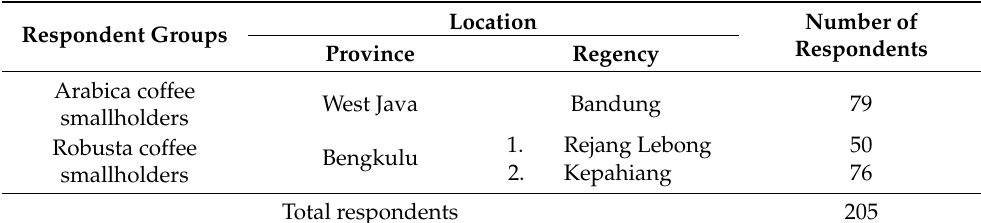
Table 1. Location and the number of